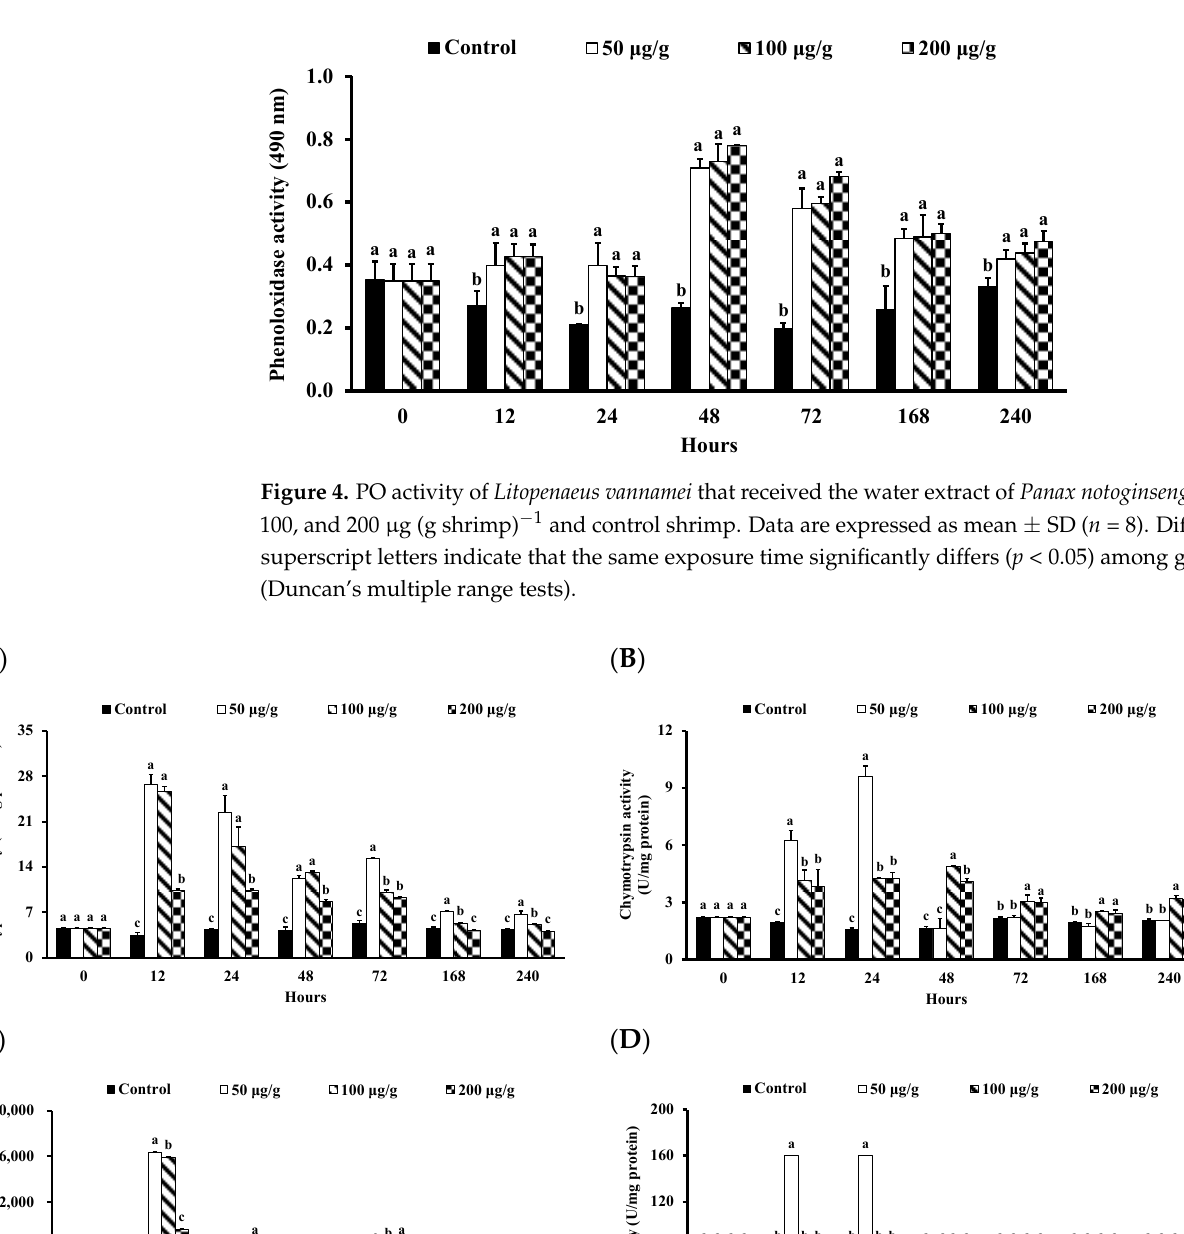
Figure 3. RB ( A ) activity, PR ( B ), and PI ( C ) of Litopenaeus vannamei that received the water extract mean ± SD ( n = 8). Different superscript letters indicate that the same exposure time significantly differs ( p < 0.05) among groups (Duncan’s multiple range tests).